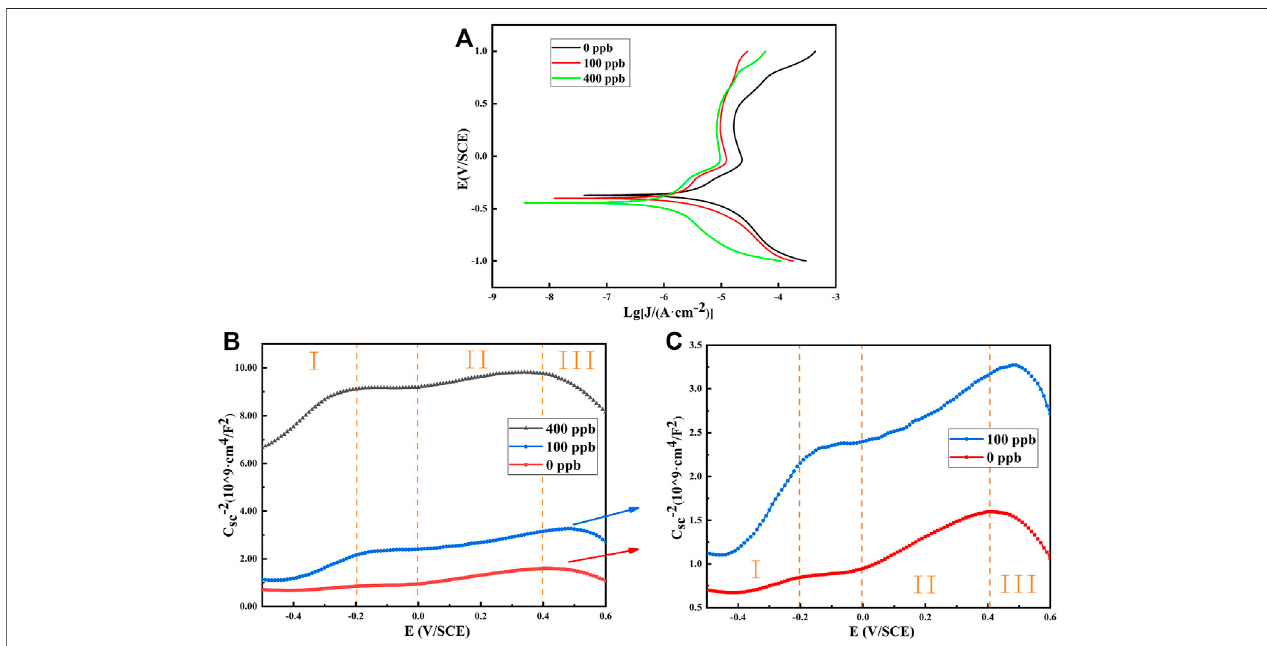
FIGURE 6 | Potentiodynamic polarization curve and Mott-Schottky curve of 304SS after exposure to different Zn solutions at 553.15 K: (A) Potentiodynamic polarization curve of 304SS with 0, 100 and 400 ppb Zn (B) Mott-Schottky curve of 304SS with 0, 100 and 400 ppb Zn (C) Mott-Schottky curve of 304SS with 0 and 100 ppb Zn.